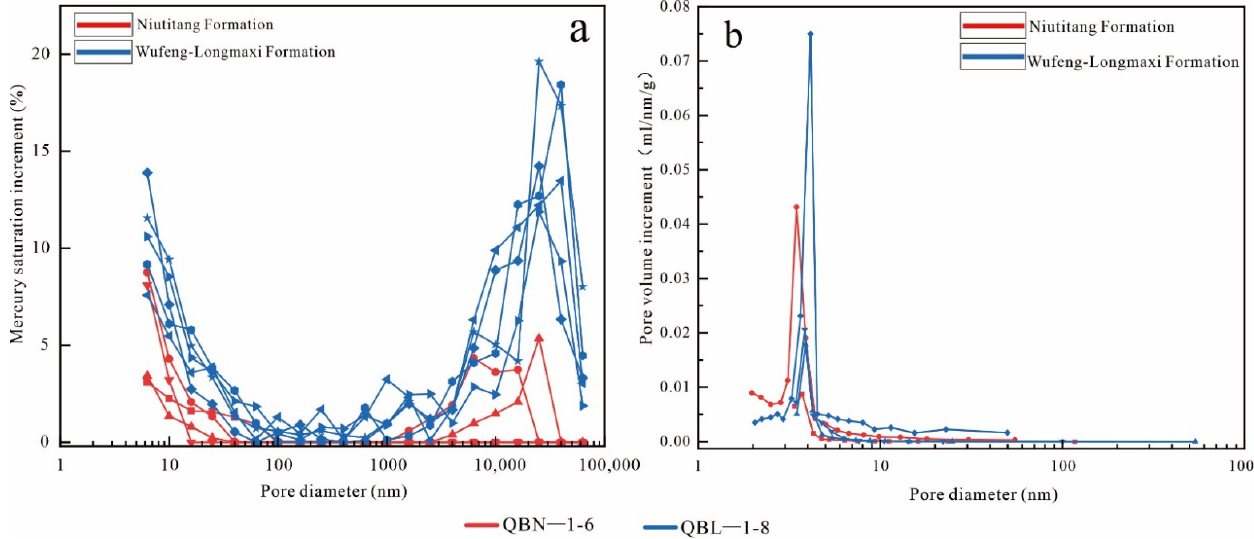
Figure 11. Multi-scale pore size distribution curves from the Wufeng-Longmaxi and Niutitang Formations. ( a ) Pore size distribution calculated by high pressure mercury; ( b ) Pore size distribution calculated by low temperature nitrogen adsorption